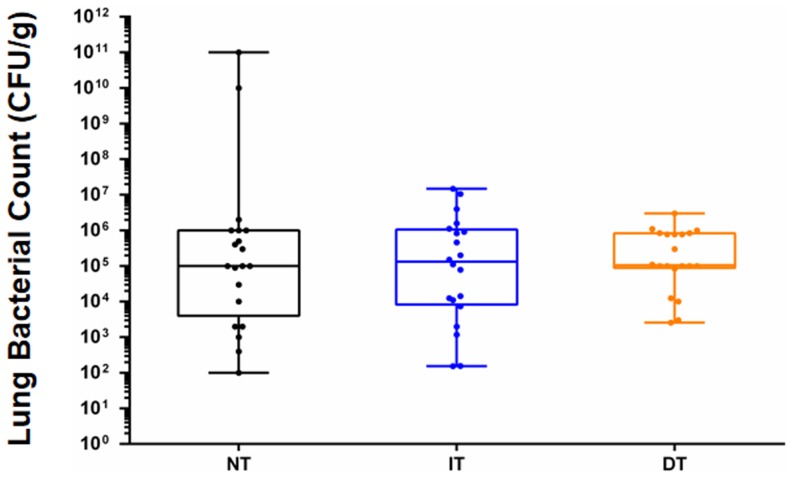
Lung bacterial count after infection.The lung bacterial count was adjusted according to the lung weight. The box plots limits represent the 25th and 75th percentiles, and the bars represent the 5th and 95th percentiles. The median is represented as a horizontal line. NT =  non-treated group; IT =  immediate treatment group; DT =  deferred treatment group.